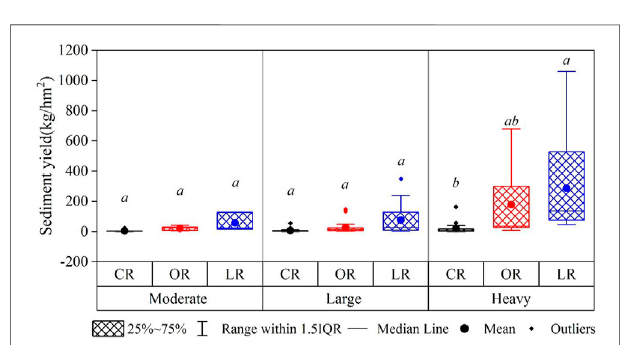
FIGURE 12 | Sediment yield of CR, OR, and LR under different rainfall patterns, and boxes labeled with different letters within groups indicate signi fi cant differences at p < 0.05. CR, OR, and LR represent cross-ridge tillage, oblique-ridge tillage, and longitudinal-ridge tillage. Moderate, large, and heavy represent moderate, large, and heavy rainfall patterns, respectively.